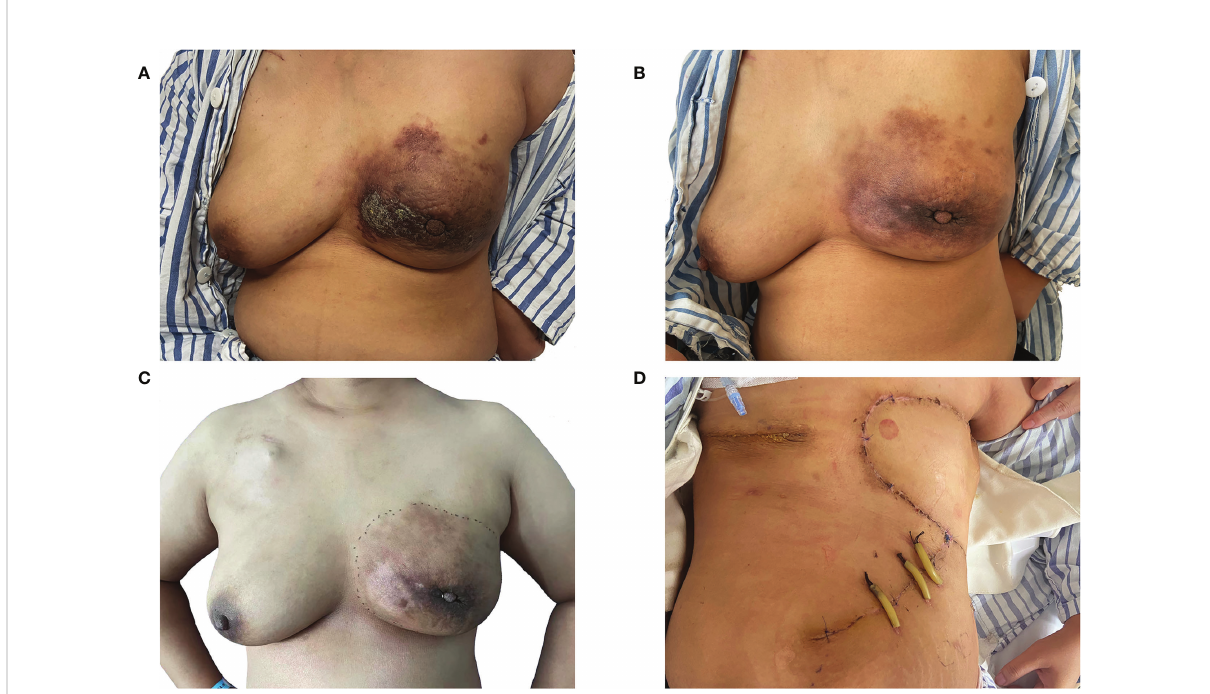
FIGURE 1 Evaluation of the therapeutic effect after chemotherapy. (A) A frontal view of the patient fi rst presenting with a red and swollen left-side breast; (B) a frontal view of the redness and swelling of the patient ’ s left breast decreasing obviously after six cycles of chemotherapy; (C) a frontal view of the patient completing 10 cycles of chemotherapy prior to a planned mastectomy; (D) a frontal view of the patient after bilateral mastectomy and local rotation skin fl ap